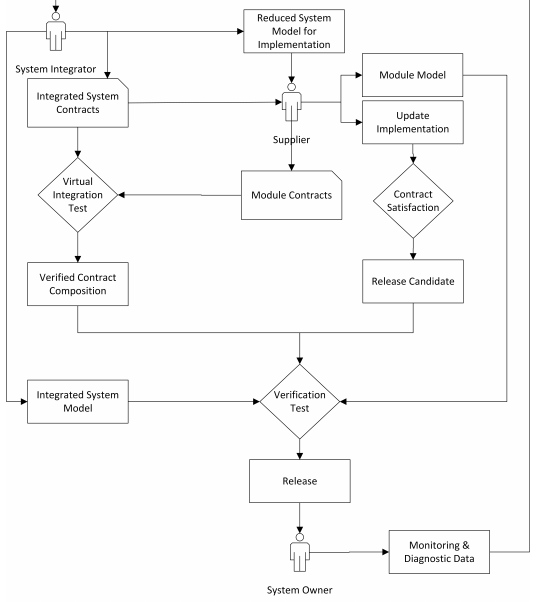
Figure 2. Communication Diagram between the different stakeholders in the